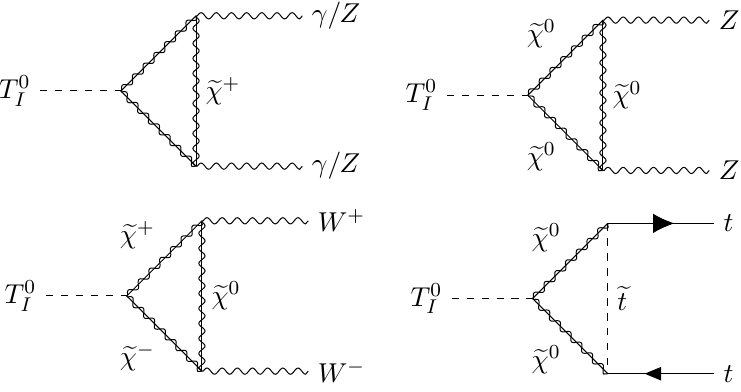
Figure 2 . The one-loop decay of S R to a quark pair.